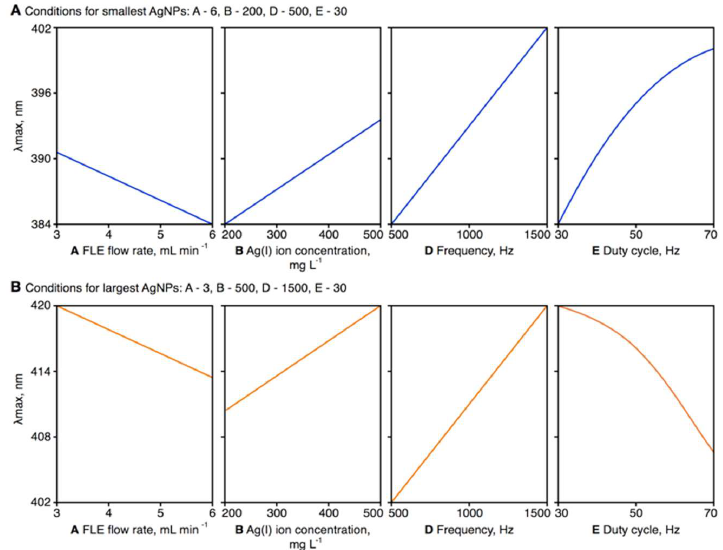
Figure 3. Graphical representation of the effects of the statistically significant parameters included in the response surface regression model on the wavelength at maximum (λ max ) of the localized surface